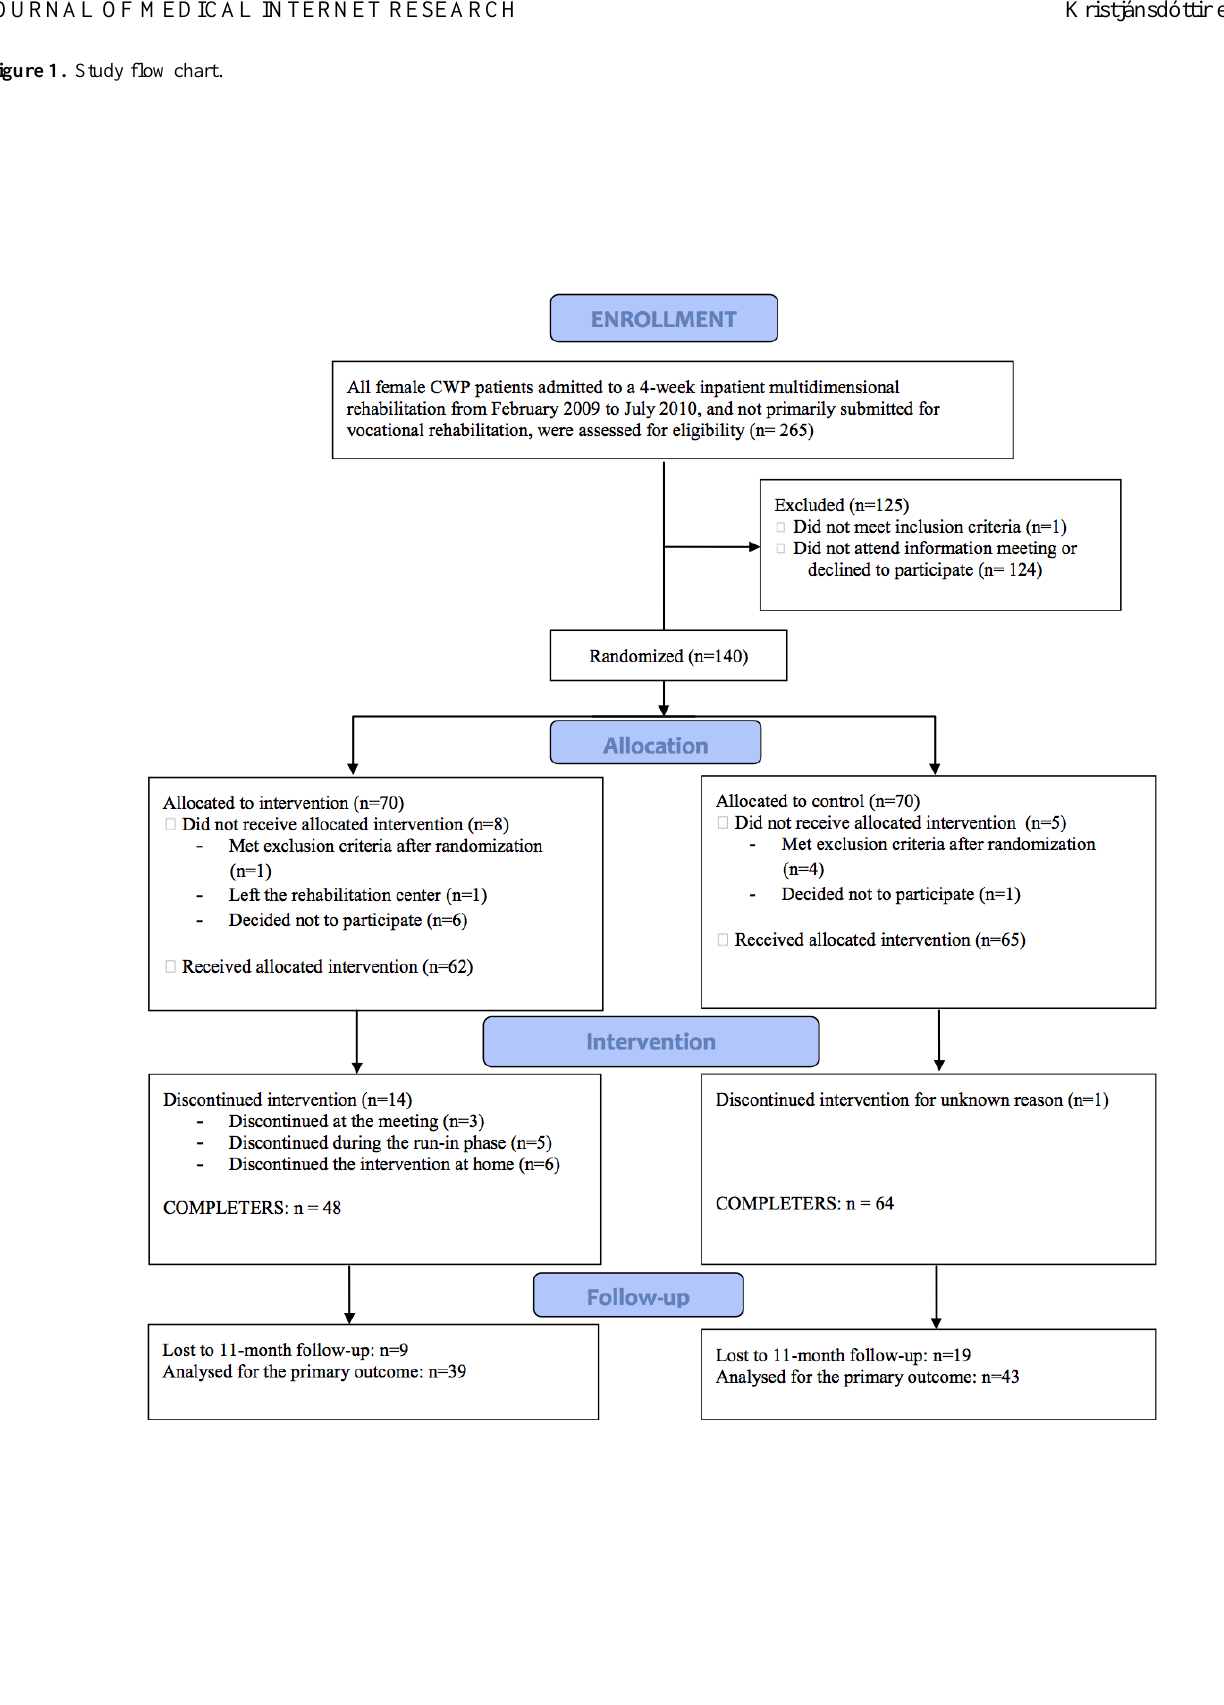
Figure 1. Study flow